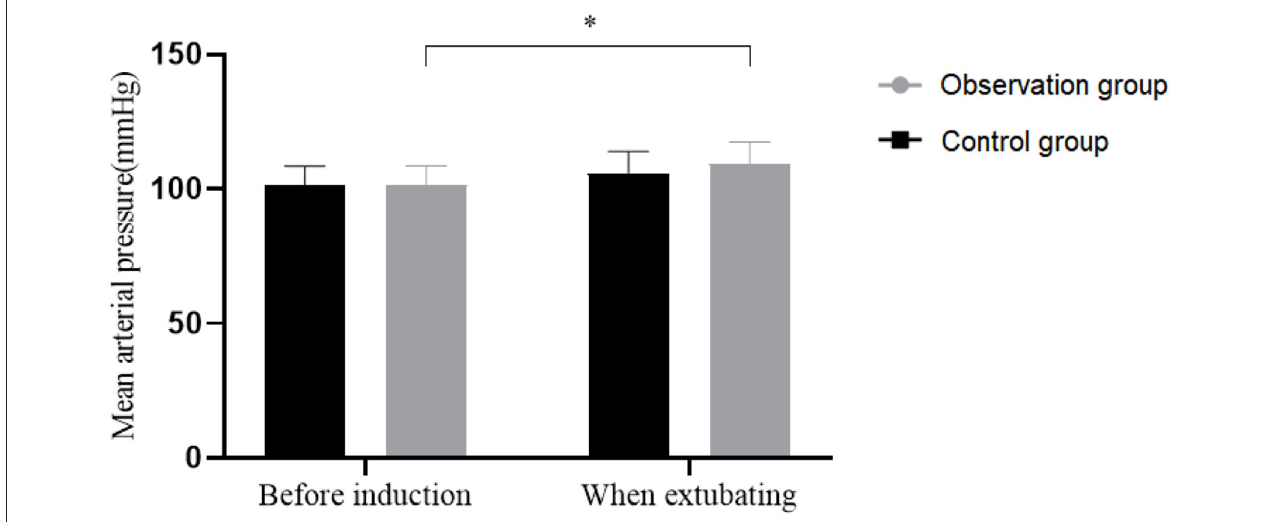
FIGURE 3 | Hemodynamics of patients. The transverse axis was pre-induction (left) and extubation (right), and the vertical axis was MAP. * P <